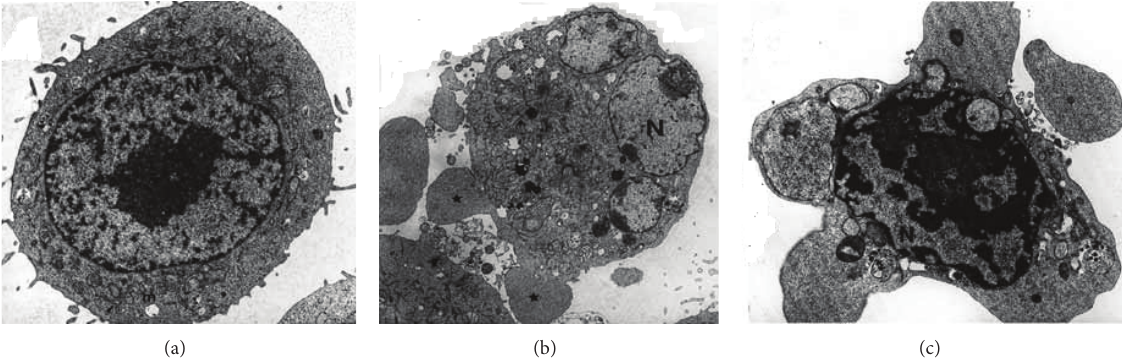
Figure 2: Ultrastructural changes associated with apoptotic cell death induced by TNF- 𝛼 (10ng/mL) in WEHI-164 cells, a murine fibrosarcoma cell line. Panel (a) shows a cell with intact cytoplasm and organelles. Panel (b) shows a cell in early apoptosis with extensive protrusion and blebbing of the plasma membrane, cytoplasmic shrinkage, and nuclear fragmentation. Panel (c) shows a cell with chromatin condensation and compact granular masses around the nuclear membrane, as well as multiple apoptotic bodies in the cytoplasm.